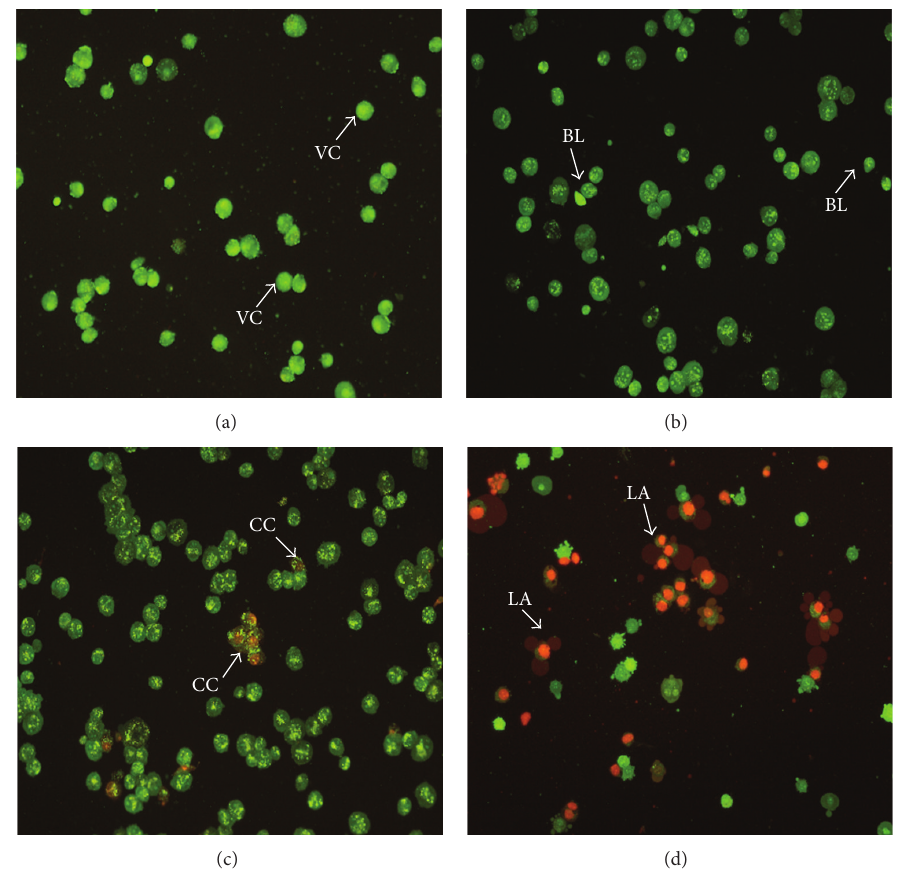
Figure 3: (a) Untreated HT-29 cells after 72 h demonstrated normal structure without prominent apoptosis or necrosis. Early apoptosis features, including blebbing and chromatin condensation, were observed after (b) 24 and (c) 48 h of treatment with Cu(BrHAP) 2 . (d) Late apoptosis was noticed after 72 h of Cu(BrHAP) 2 treatment (magnification: 200x). VI: viable cells; BL: blebbing of the cell membrane; CC: chromatin condensation; LA: late